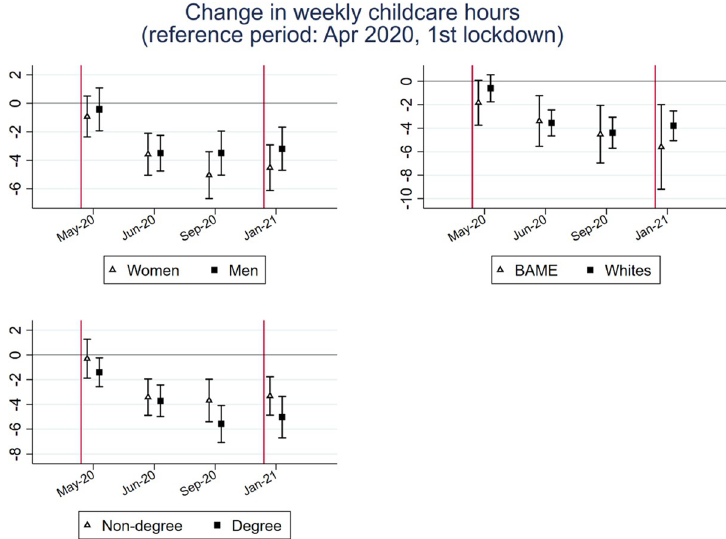
Fig 10. Point estimates and 95% confidence interval of the gender, race, and education-period interaction models.